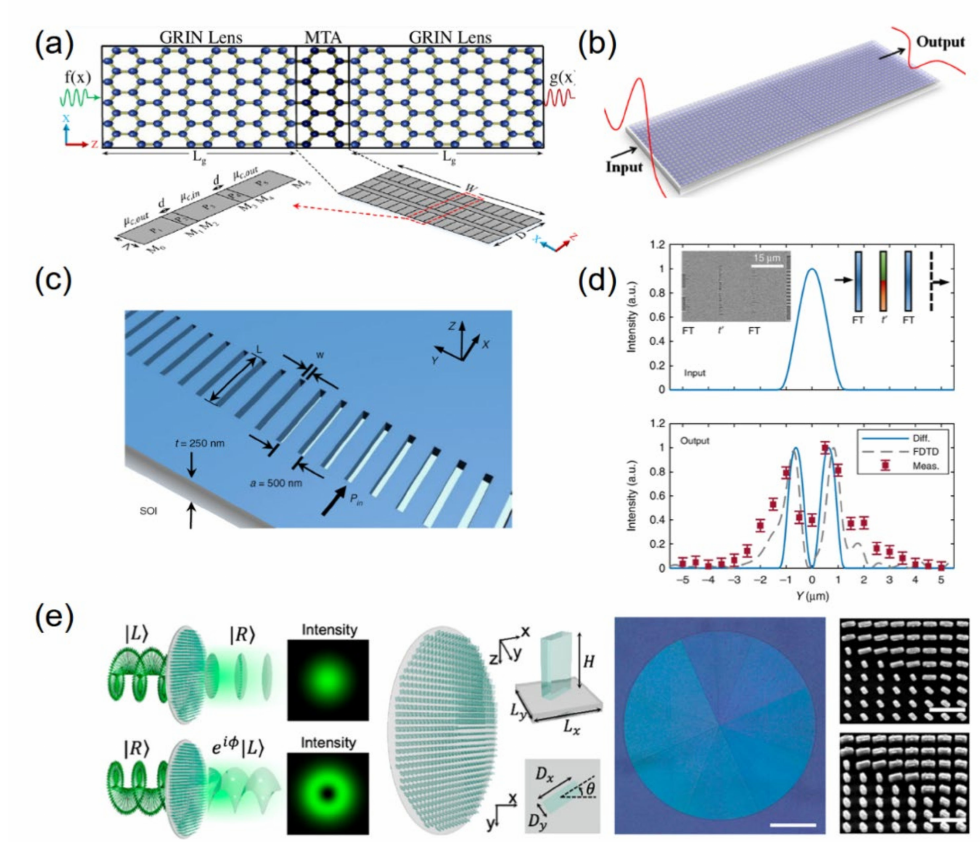
Figure 3. ( a ) The sketch of graphene-based metaline; adapted with permission from [32] © The Optical Society. ( b ) Dielectric metamaterial with drilling hole arrays to solving second-order differential equation; adapted with permission from [123], IOP Publishing, 2016. ( c ) Schematic of on-chip 1D high-contrast transmitarray, the rectangular slot arrays are etched on the silicon-on-insulator (SOI) substrate with the period of 500 nm. ( d ) Comparison of the input (top) and output (bottom) intensity profile of an on-chip differentiator; adapted with permission from [100], Springer Nature, 2019. ( e ) Left: schematic of the concept for spin-dependent function control; middle: schematic of the dielectric metasurface spatial filter; right: photograph of the fabricated metasurface. Scale bar: 500 µ m. Insets: scanning electron micrographs showing the top and oblique view of TiO 2 nanopillar array. Scale bar: 1 µ m. Adapted with permission from [125], ACS Publications,